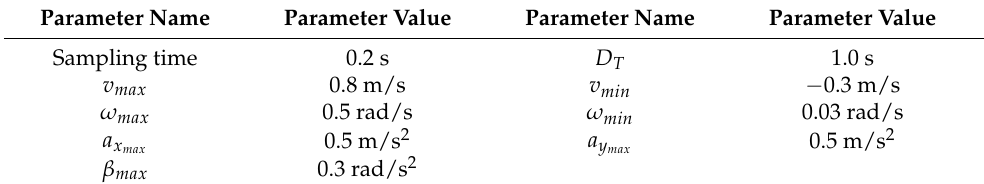
Table 5. Path planning parameter